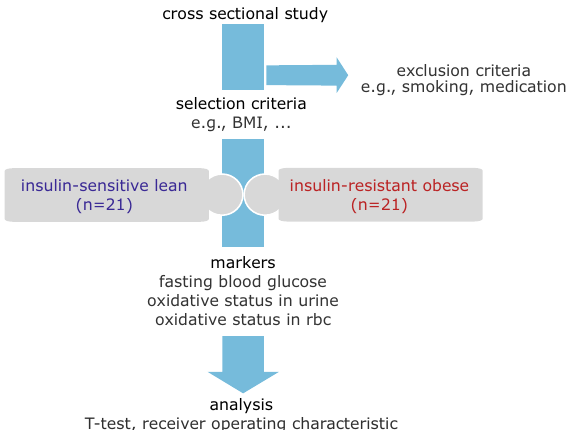
Fig. 7 Study design: performance analysis of the proposed markers. a A cross-sectional, observational study was conducted to evaluate the proposed oxidative stress biomarker against the gold standard (urinary F 2 -IsoP). Subjects were recruited based on a number of selection (e.g., insulin sensitivity) and exclusion (e.g., smoker) criterion (details in “ Methods ” ). Two distinctive group of subjects established were the insulin-resistant obese subjects ( n = 21), and insulin-sensitive lean subjects ( n = 21) with demographic as shown in Table 1. The biomarkers evaluated were oxidative stress in red blood cells (the proposed technique), oxidative stress in urine F 2 -IsoP, and fasting blood glucose.